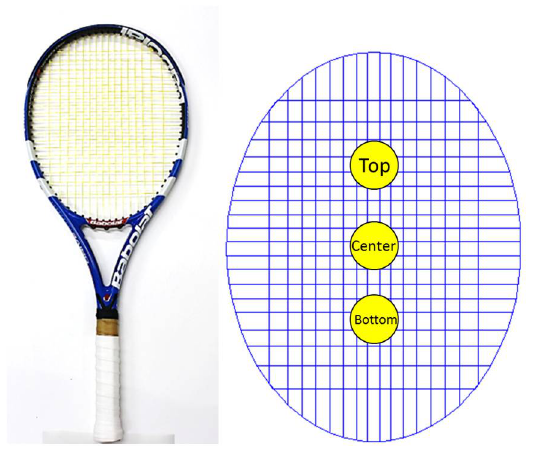
Figure 10. Tennis racket for